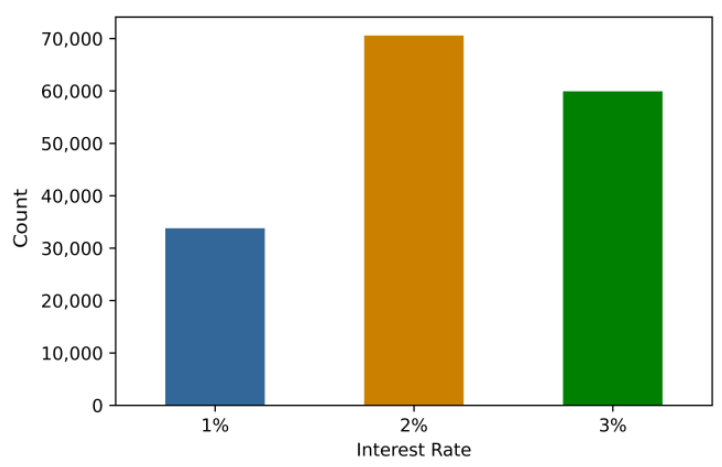
Figure 5. Distribution of dataset 3